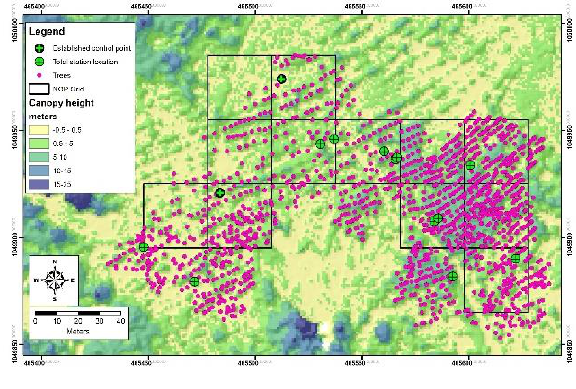
Figure 2. Survey points